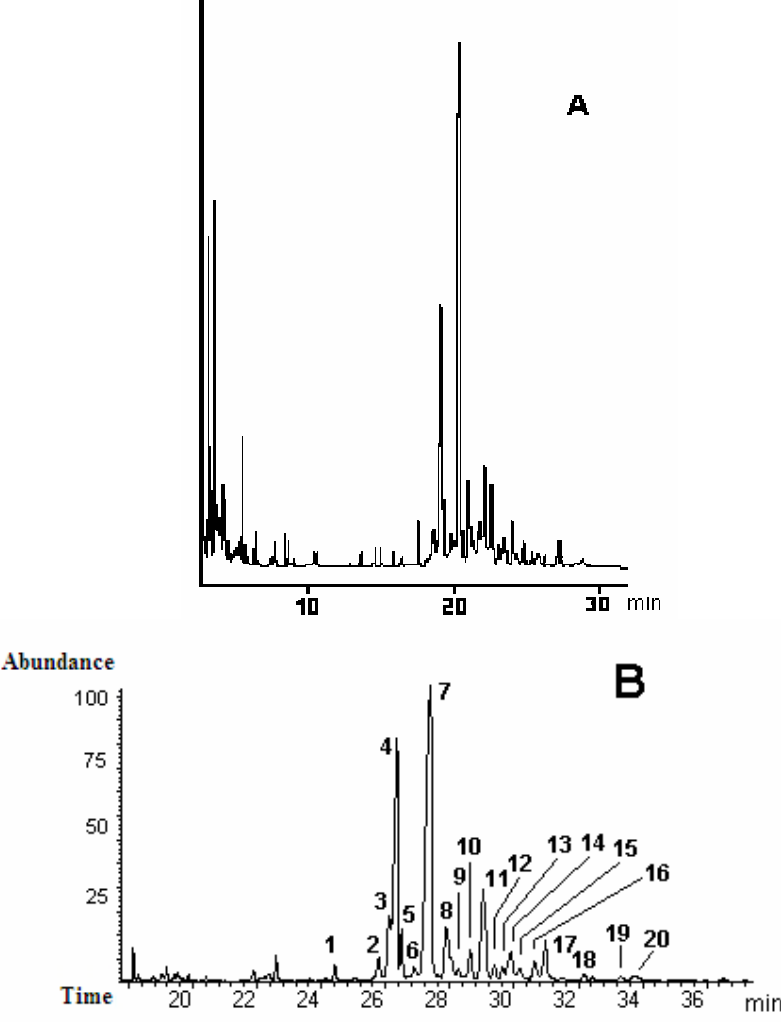
Fig. 1 – A) HRGC chromatogram of fraction containing pentacyclic triterpenes from V. graminifolia and B) Partial Total Ions Chromatogram (TIC) after recrystallization of the fraction. Mass spectra: see Table